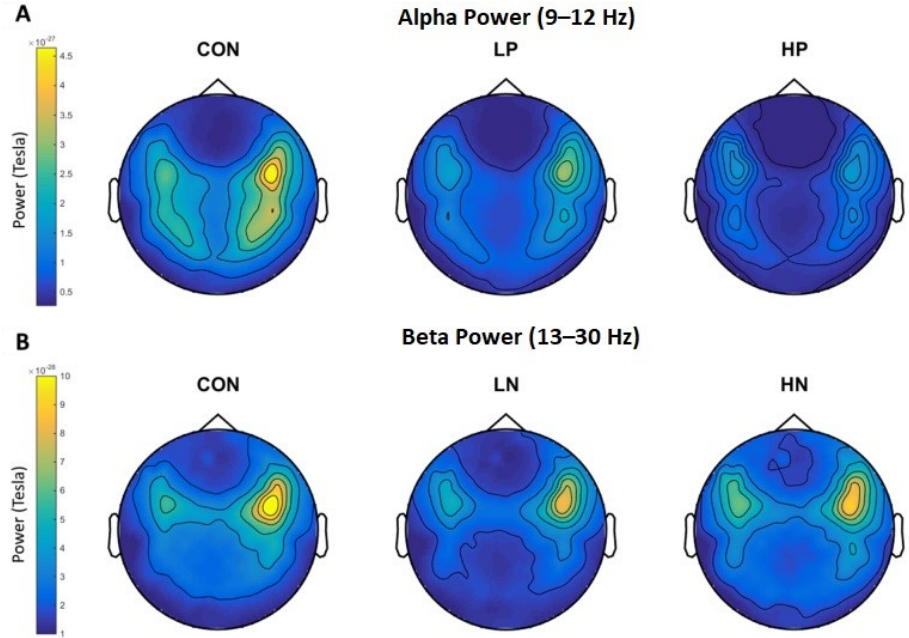
Figure 7. Topoplots of alpha power ( A ) for Con, Low positive (LP), and High Positive (HP); and of beta power ( B ) for Con, Low Negative (LN), and High Negative (HN) Schizophrenia patients. Colors represent power levels. Reprinted from [91]. (Copyright 2018 Elsevier) Image reproduced with copyright permission.